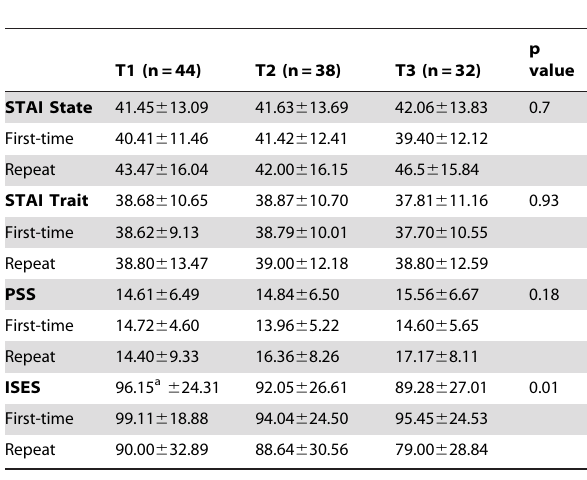
Table 2. T1, T2, and T3 scores in all